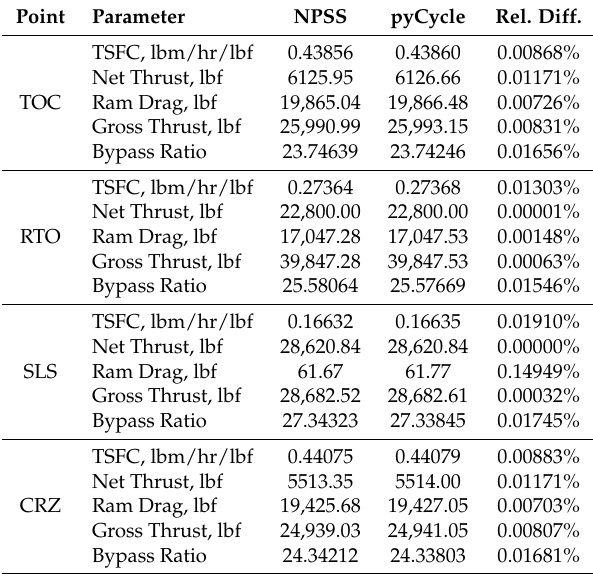
Figure 8. Relative difference between pyCycle and NPSS thermodynamic properties for the MDP N + 3 reference engine model. Table 4. Relative difference between pyCycle and NPSS performance properties for the MDP N + 3 reference engine